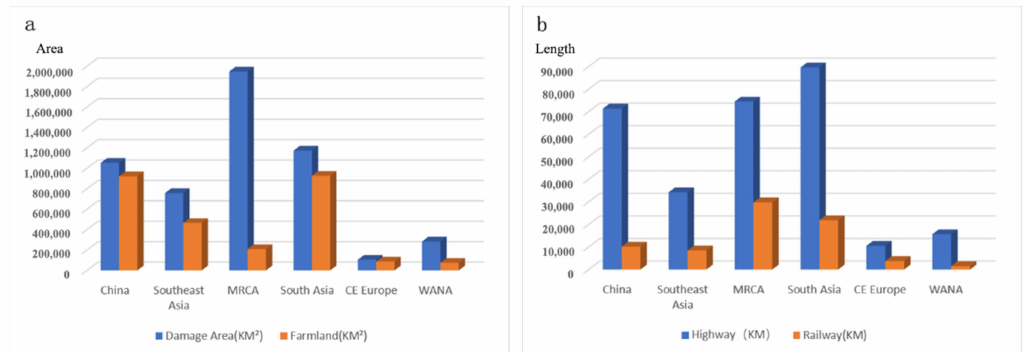
Figure 7. ( a ) Statistic of floods potential affected land and cropland along the “Belt and Road” zone in 2016; ( b ) Statistic of floods potential affected railway and highway along the “Belt and Road” zone in 2016.